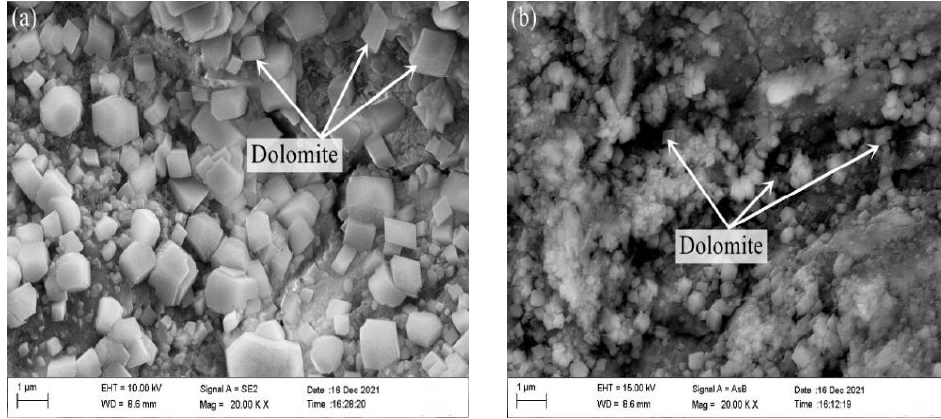
Figure 11. SEM image of the product in fracture surface of aggregate S1# in the concrete microbars cured in 1M NaOH solution at 80 °C for 28 days: ( a ) 50% metakaolin. ( b ) 50% fly ash.